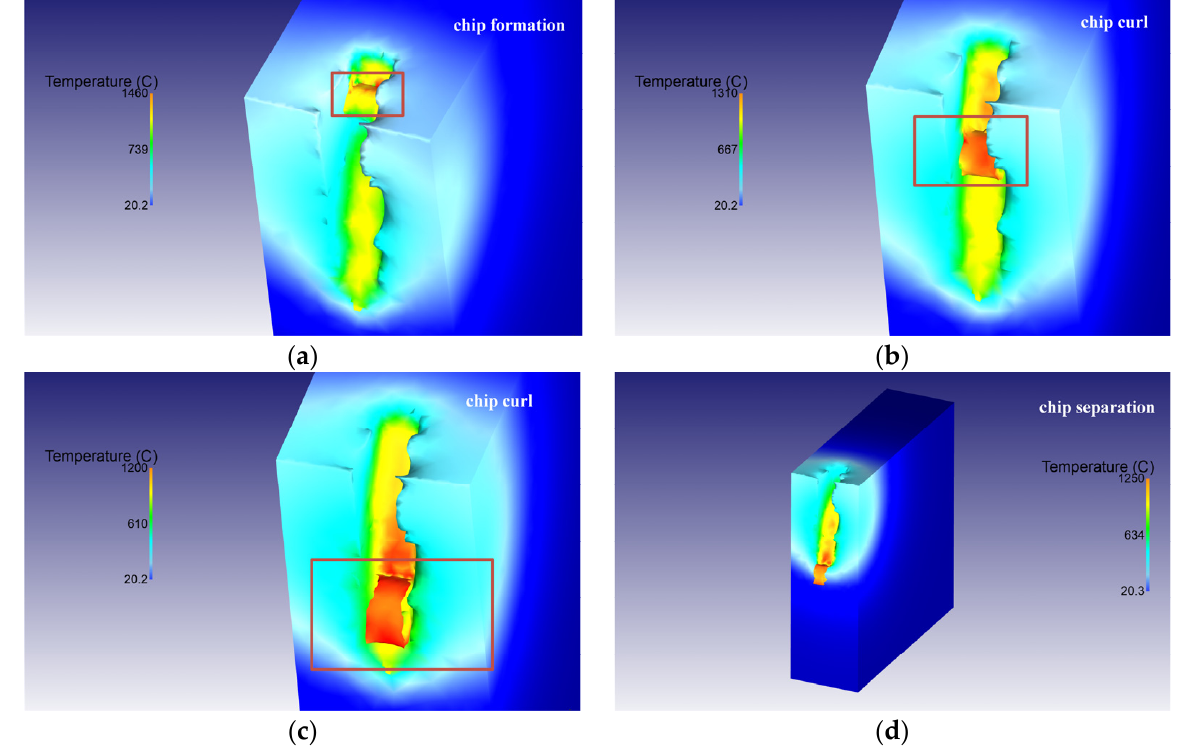
Figure 17. Single sawtooth cutting square workpiece temperature field. ( a ) chip formation; ( b ) chip curl-1; ( c ) chip curl-2; ( d ) chip separation.